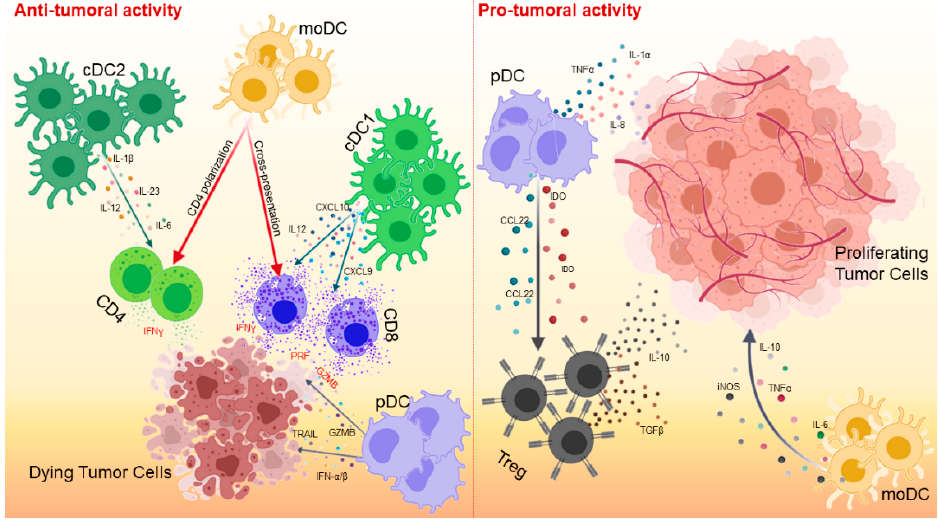
Figure 1. Activity of dendritic cell (DC) subsets in cancer immunity. In the TME, DCs can have both an anti-tumor and pro-tumor effect. Anti-tumor activity is mainly driven by cDC1s and cDC2s (left panel). cDC1s induce recruitment and activation of CD8 + T lymphocytes in the TME through cytokine production and cross-presentation of tumor antigens, respectively. cDC2s are the major activators of CD4 + T cells. moDCs act mainly by stimulating cDC1s and cDC2s, whereas pDCs kill tumor cells through the expression of IFN- α / β , TRAIL and Granzyme B (GZMB). moDCs and pDCs may also have a pro-tumor action by creating an immunosuppressive environment and promoting tumor growth (right panel). moDCs produce molecules with immunosuppressive function such as iNOS, TNF α , IL-6 and IL-10. pDCs secrete chemokines able to recruit Tregs into the TME (CCL22 and IDO) as well as pro-angiogenic cytokines (TNF α , IL-8, and IL-1 α